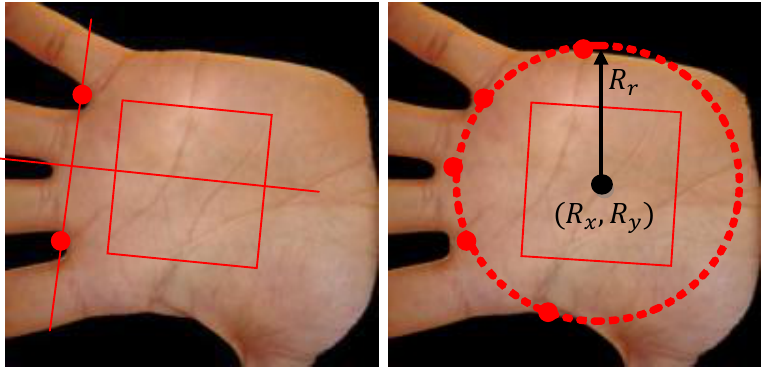
Figure 13. Palmprint ROI extraction methods, traditional [33] method (left) and proposed method